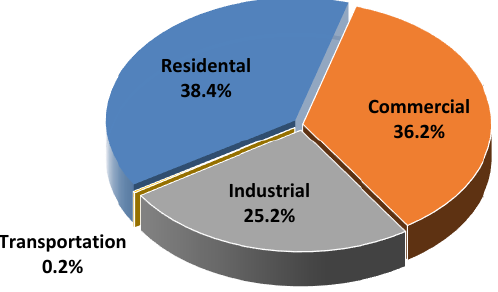
Figure 1. Breakdown of electricity consumption in the US (2015) [43].